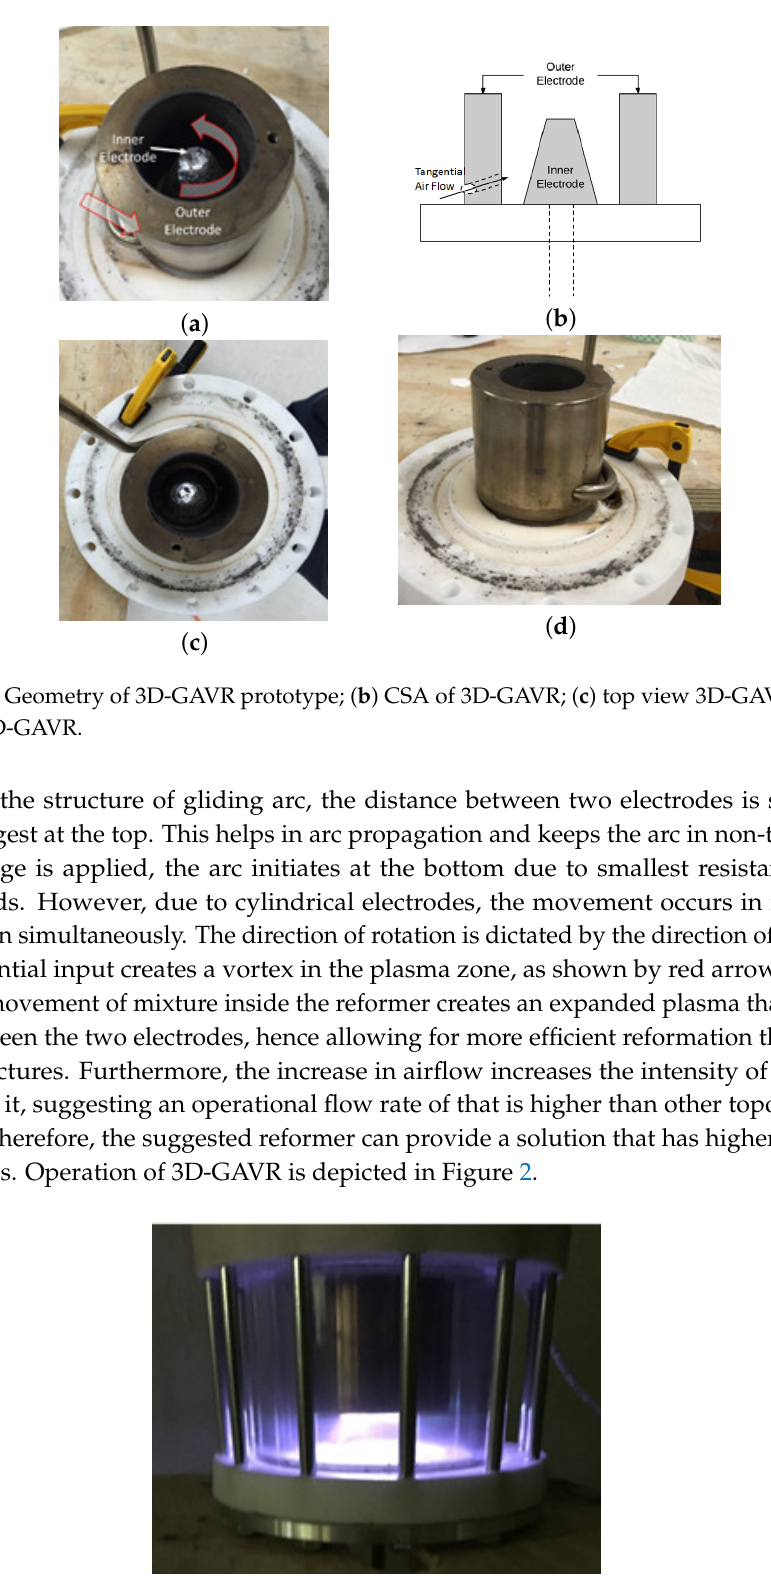
Figure 2. 3D-GAVR